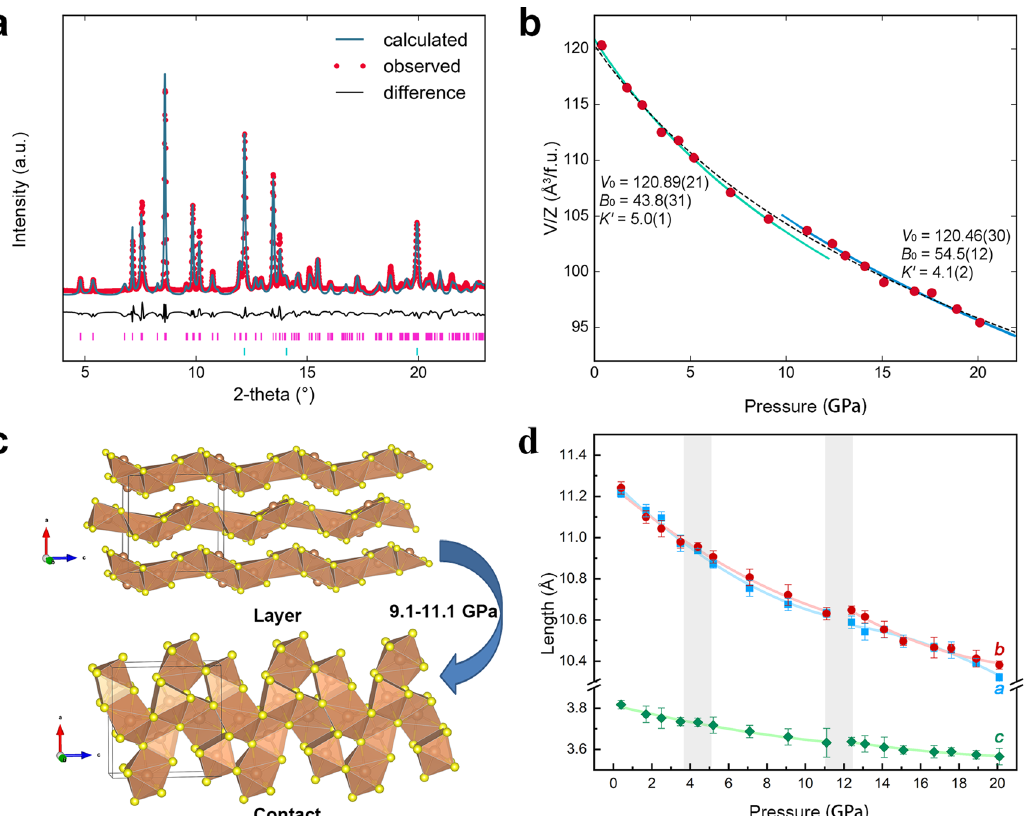
Fig. 1 XRD and EOS fi tting result. a Rietveld re fi nements results of Sb 2 S 3 at 11 GPa. b P – V data is fi tted to the third-order Birch-Murnaghan equation. Solid lines were fi t to two segments of data while dashed line was fi t for the whole range of data with V 0 = 120.3(7) Å 3 /f.u. , K 0 = 48(6) GPa and K ′ = 5.4(9). Volume uncertainties are generally smaller than the size of symbols. c the signature layered chains of SbS 5 polyhedral collapsed into a bulky structure in between 9.1 and 11.1 GPa. d Evaluation of crystal structure parameters up to 20.6 GPa. The errorbars in cell volume and lattice parameters were generated by the re fi nement of X-ray diffraction pattern and the Unitcell fi tting Supplementary Fig. 2 and the evolution of interlayer distance in Supplementary Fig. 3. A clear stiffening of lattice was observed near the isostructural transition point, where the B 0 of reconstructed 3D-Sb 2 S 3 is 24% greater ( B 0 = 54.4 GPa compared to 43.8 GPa for the low-pressure phase). Seeing from the evolution of structural parameters (Fig. 1c, d), the compression in low-pressure phase is mainly achieved by squeezing layers made of Sb – S polyhedral chains. Above the transition point, the material becomes less-compressible as the Sb 2 S 3 features higher atomic coordination described in the 3D structure. A notable jump of the c axis length is observed at 11 GPa, accompanying the shortening of a and b lattice axis and the isostructural transition.